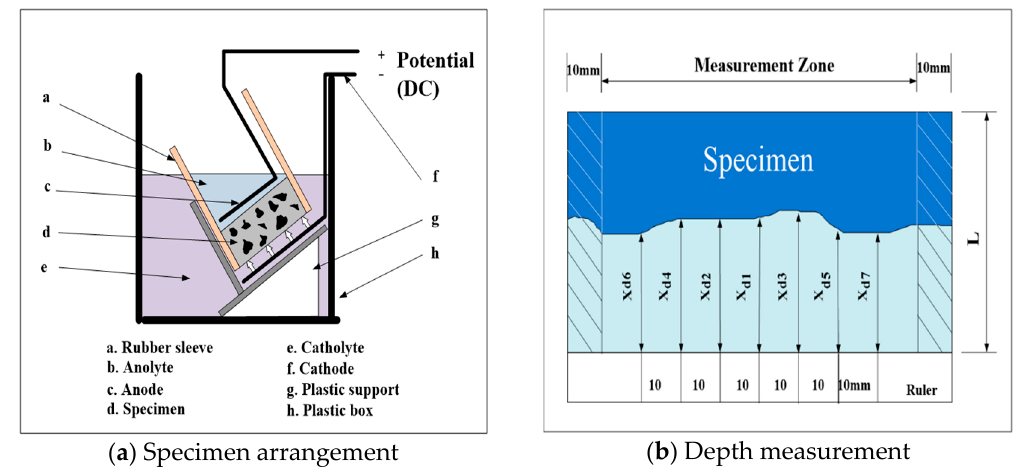
Figure 3. Schematic arrangement of the migration test.